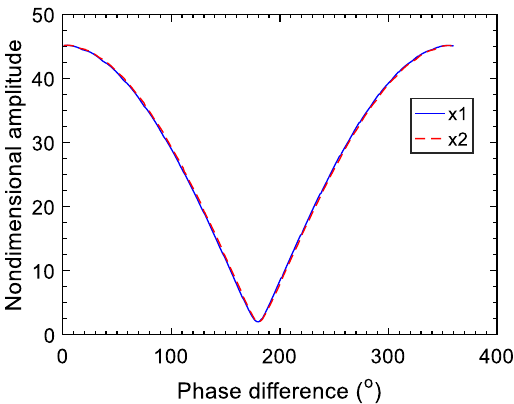
Figure 12. Nondimensional amplitude vs. phase difference ( o ) (𝛾 𝑛𝑒𝑡 = 0.9) .